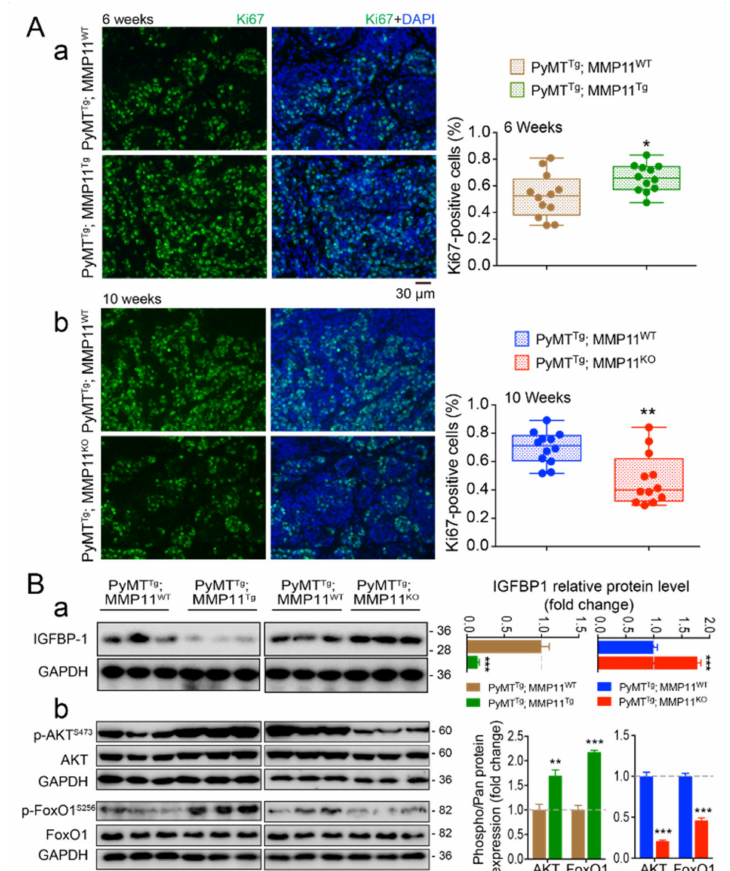
Figure 3. ( A ) MMP11 promotes tumor cell proliferation at early stage of tumor development. Immunofluorescence staining shows increased percentage of Ki-67-positive cells in the tumors of 6-week-old PyMT Tg ; MMP11 Tg mice ( a ), whereas tumors from 10-week-old PyMT Tg ; MMP11 KO animals ( b ) have less proliferating cells compared with their respective controls; ( B ) Left panel: Western blot protein expression profiles of Insulin-like growth factor-binding protein 1 (IGFBP1) ( a ) and of components of its downstream IGF1 / AKT / FoxO1 signaling pathway ( b ) reveal activation of this cascade in representative tumors from 6-week-old PyMT Tg ; MMP11 Tg mice and its decrease in tumors from 10-week-old PyMT Tg ; MMP11 KO animals as compared to their respective control animals. Right panel: quantification of the ratios of phosphorylated proteins to total level compared to wildtype are presented, n = 6–8 mice / group, data are expressed as mean ± SEM, * p < 0.05, ** p < 0.01, *** p < 0.001 (unpaired t